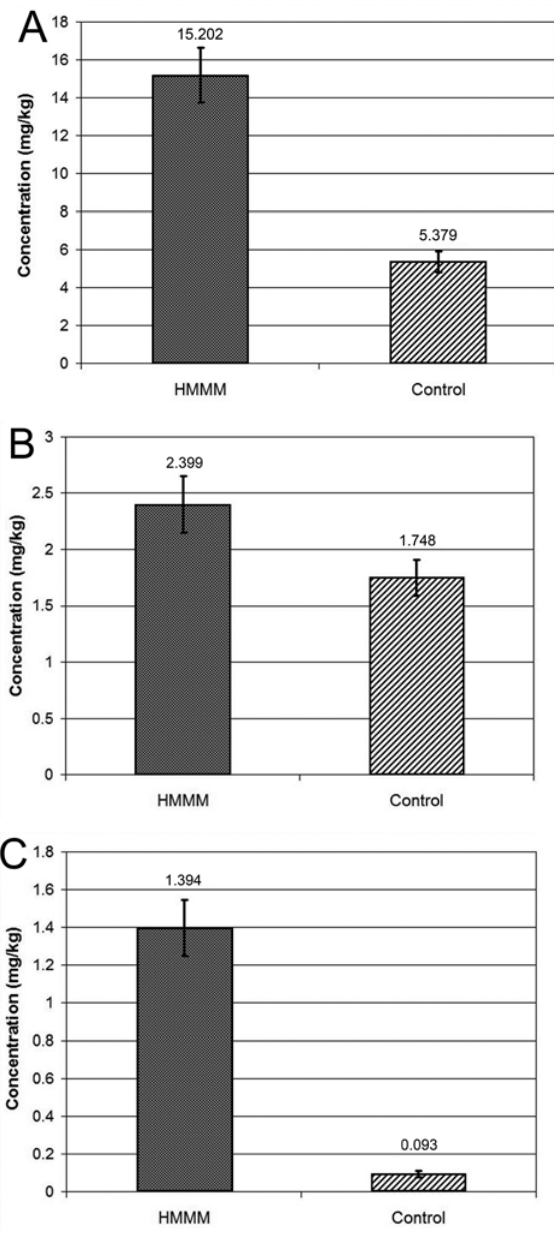
Fig. 2. Heavy metal concentration in body tissues of mixture- exposed Gibel carp (HMMM): muscle (A), gills (B) and liver (C) (Mean±SD). Asterisks (*) denote values significantly different from control ( p ≤